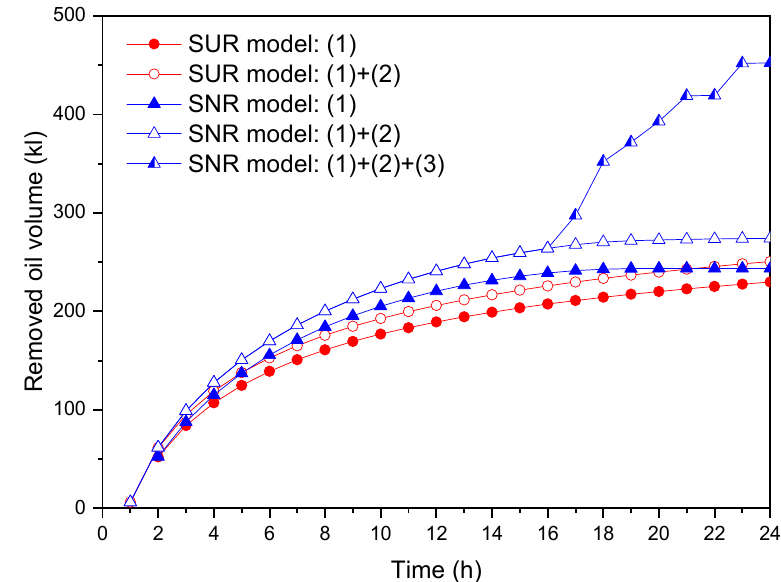
Figure 6. Comparison of the cumulative volume of removed oil between the SUR model and the SNR model: (1) volume of oil recovered by the skimming systems, (2) volume removed by weathering, (3) volume dissipated by thin slicks with an oil thickness of less than 0.6 μ m.